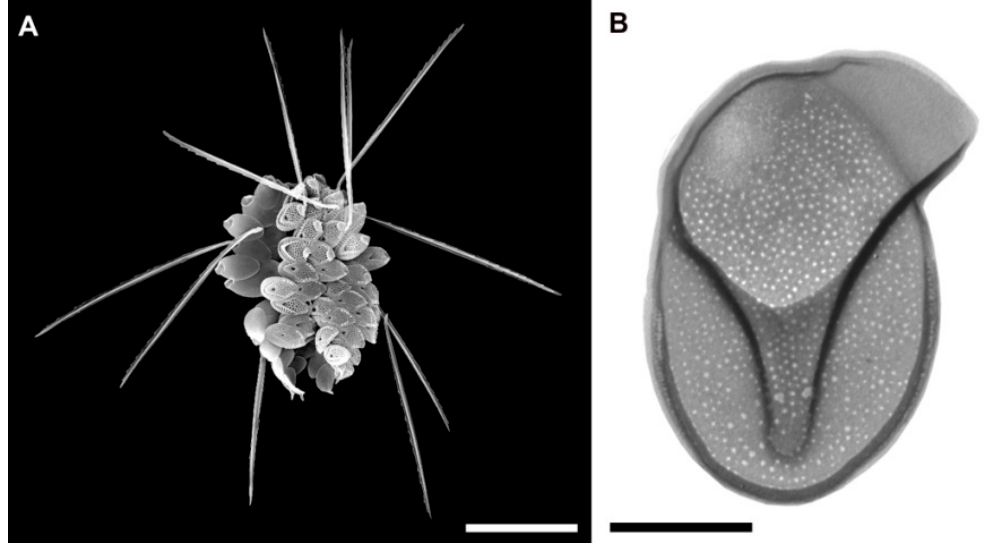
Figure 1. Micrographs of silica ‐ scaled chrysophytes of the genus Mallomonas (ASEM; B—TEM). ( A ) Cell of Mallomonas crassisquama var. papillosa ; ( B ) scale of M. vannigera . Scale: ( A ) 10 μ m; ( B ) 2 μ m.